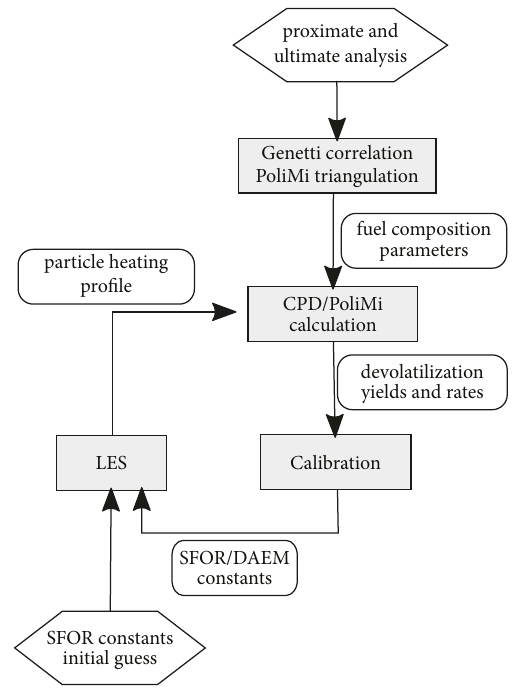
Figure 3: Flowchart of the calibration process. Adapted from [17].